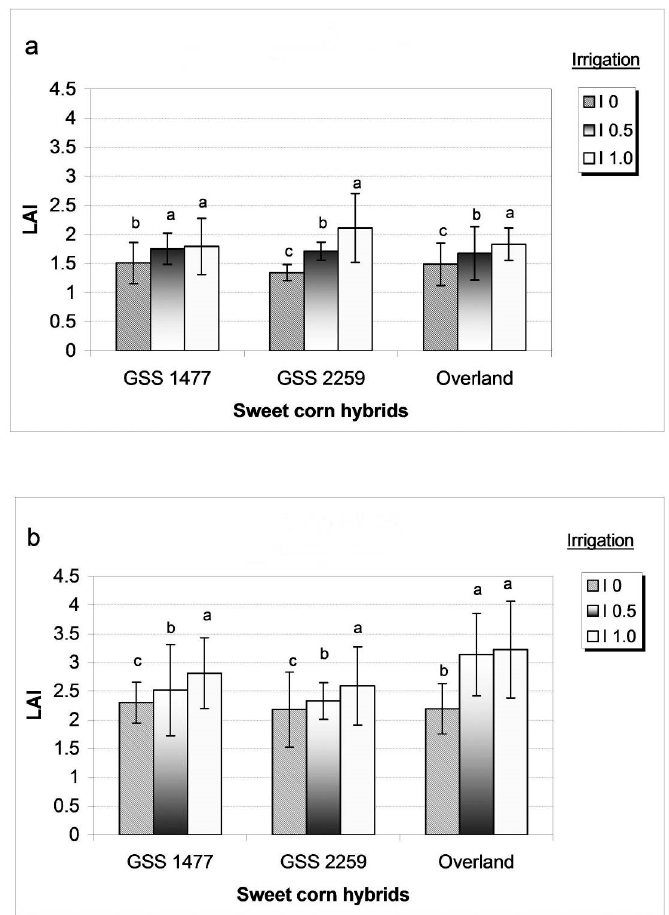
Figure 5. Effect of water supply on LAI ( a ) during tasseling and ( b ) during silking of sweet corn. The data presented the average of years ± SD. Mean values followed by the different letters are significantly different at the p < 0.05 level. I 1.0 = regularly irrigated I 0.5 = moderate water deficit I 0 = unirrigated, severe dry conditions.